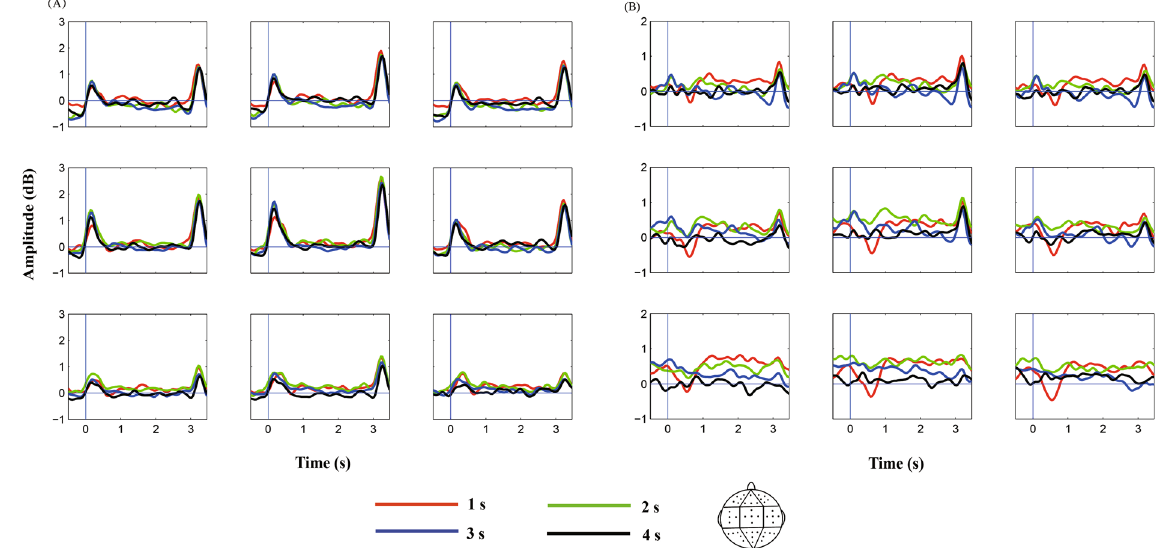
Figure 3. Average theta ( A ) and alpha ( B ) band powers during the 1-s, 2-s, 3-s, and 4-s auditory duration maintenance in WM. Steady theta (4–8 Hz) and alpha (8–12 Hz) band activities are elicited during WM maintenance after averaging across frequency, and they are separately plotted for each of the nine analysed electrode clusters. Zero on the x-axis represents the onset of the delay phase. Red, green, blue, and black curves denote the 1-s, 2-s, 3-s, and 4-s auditory duration conditions,